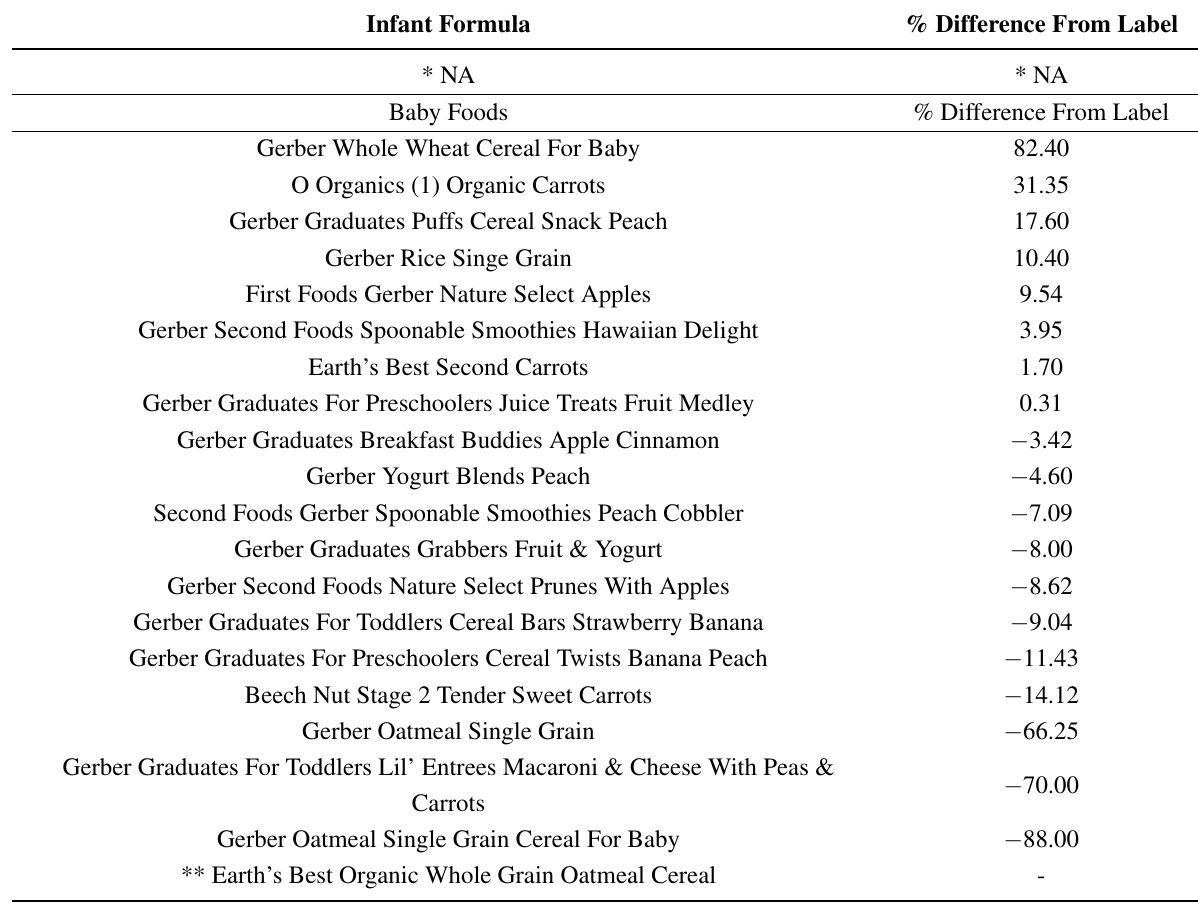
Table 2. Comparison of per serving sugar: Laboratory measured vs. nutrition label